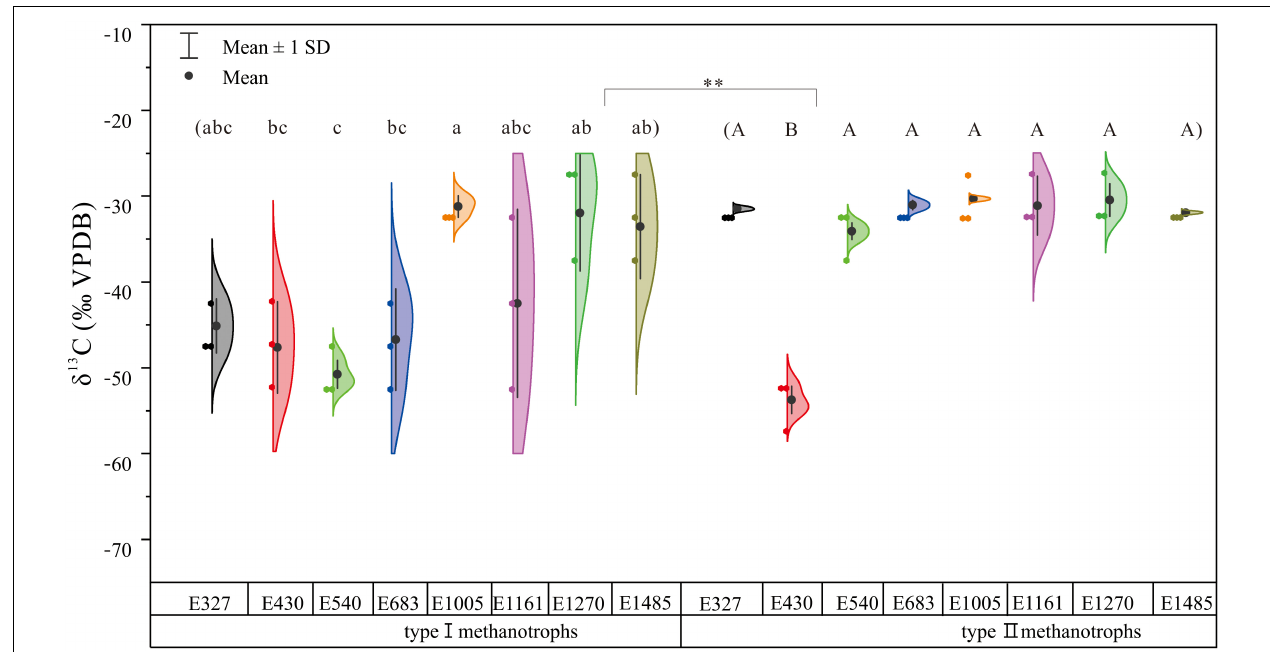
FIGURE 4 | The δ 13 C values of type I and type II methanotroph biomarkers based on phospholipid fatty acids along the altitude gradient on the northern slope of the Changbai Mountain, China. Different letters indicate significant differences among study sites based on one-way ANOVA and Tukey’s test ( p < 0.05). The asterisk represents the difference between type I and type II methanotrophs ( ∗∗ p < 0.01). The δ 13 C values of type I methanotroph biomarkers were the average δ 13 C values of 16:1 ω 7c and 16:1 ω 5c.